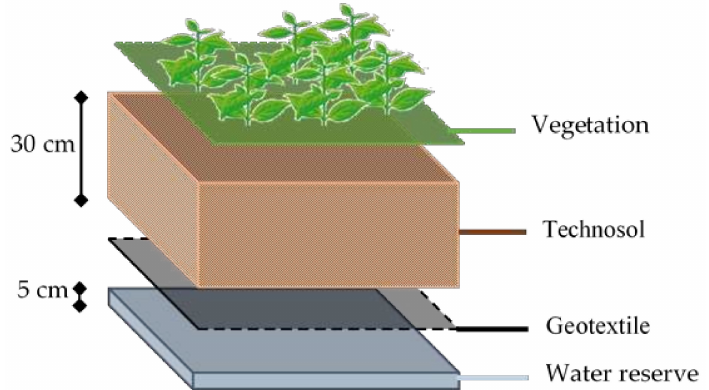
Figure 2. Vertical organization of an experimental plot on the T4P research